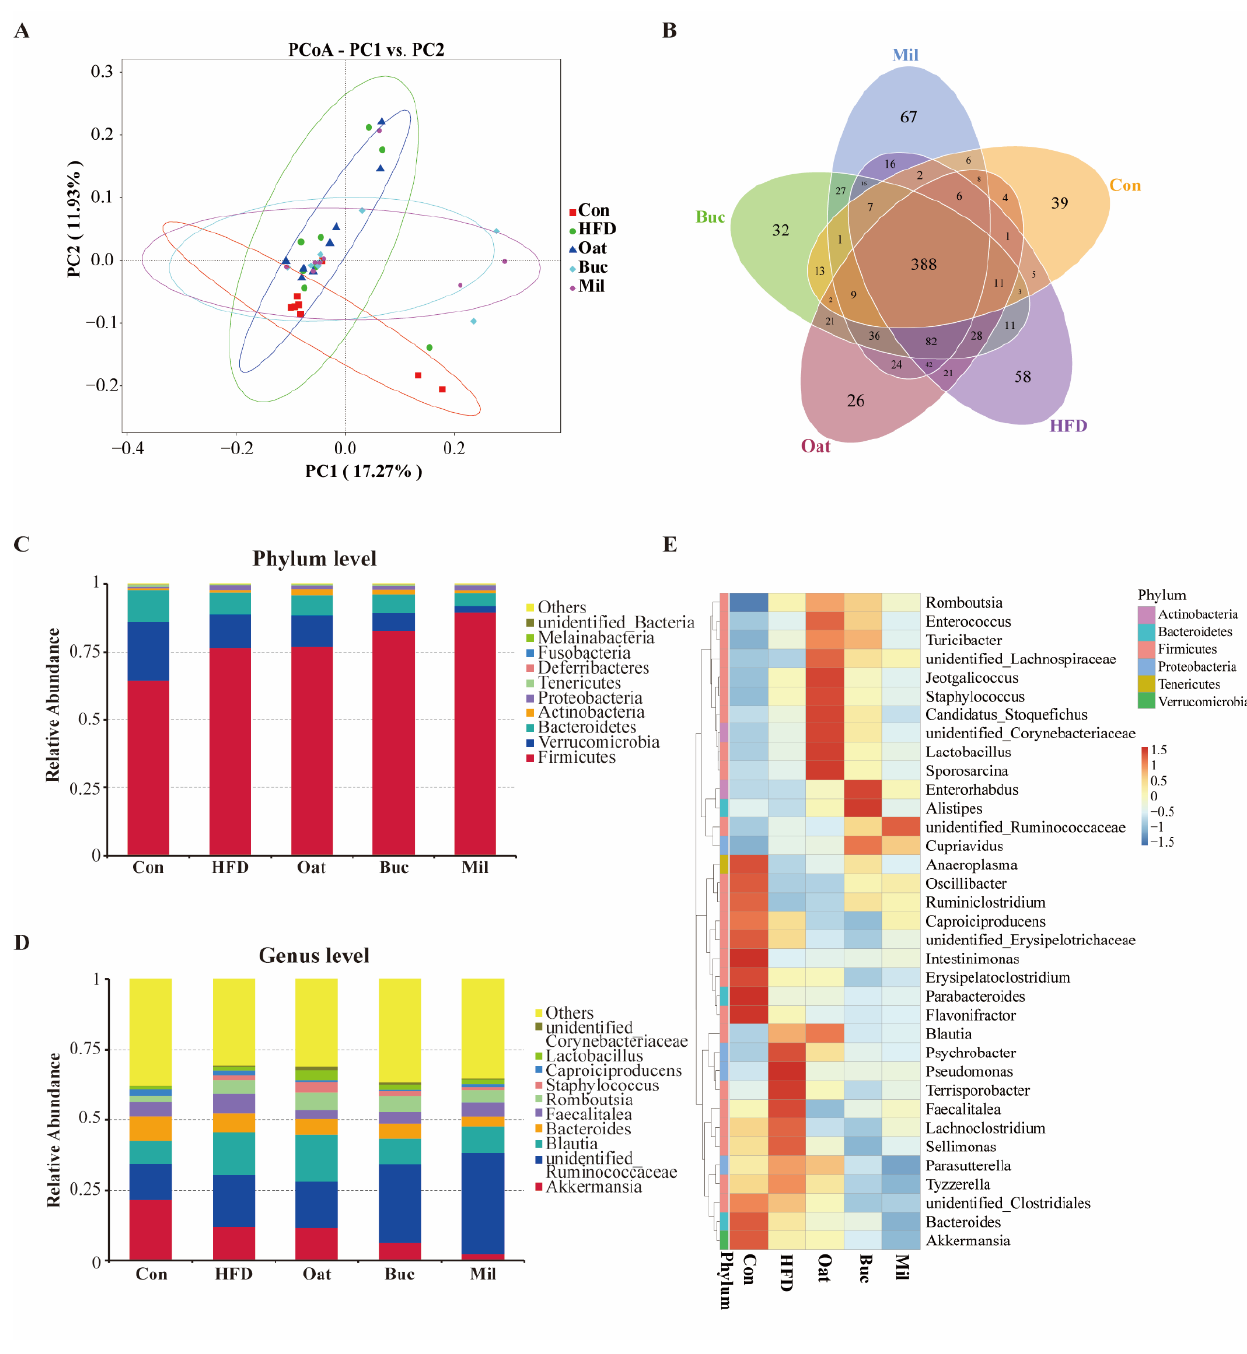
Figure 6. Effect of oats, tartary buckwheat, and foxtail millet supplementation on gut microbiota composition in high-fat diet fed rats. ( A ) Principal coordinate analysis (PCoA) of colonic microbiota ( n = 8). ( B ) Venn diagram showing the shared and unique OTUs among the five groups. ( C ) Microbial community composition at the phylum level. ( D ) Microbial community composition at the genus level. ( E ) Heatmap of clustering analysis at the genus level. Con group, a basal diet group; HFD group, a high-fat diet group; Oat group, HFD containing 22% oat group; Buc group, HFD containing 22% tartary buckwheat group; Mil group, HFD containing 22% foxtail millet group.